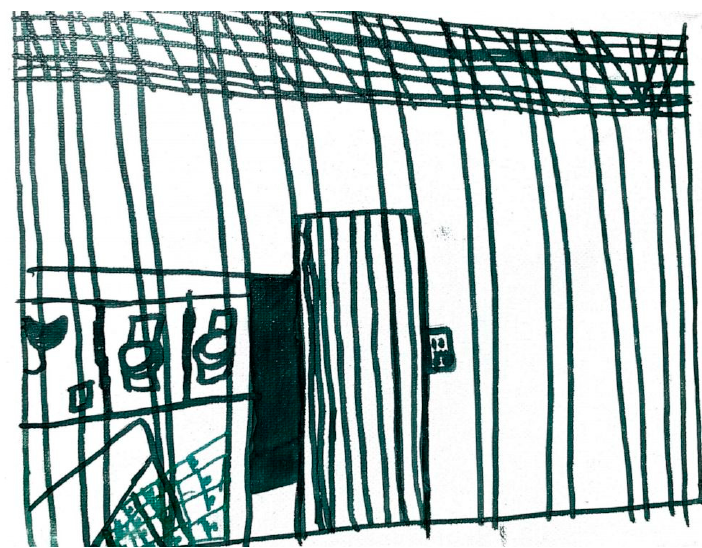
Figure 7. Drawing by primary school age child, gender redacted, held in an unspecified US detention Center, 2019. Courtesy of American Academy of Pediatrics.